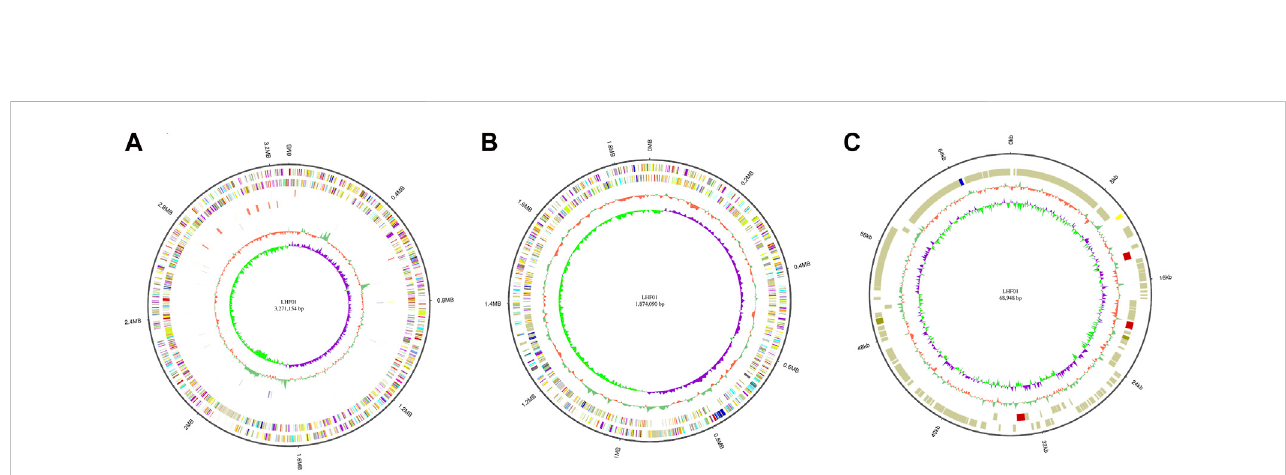
FIGURE 2 Genome map of V. alginolyticus LHF01. (A) , chromosome 1. (B) , chromosome 2. (C) , endogenous